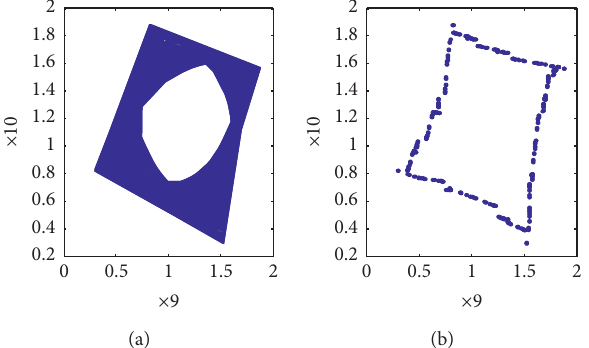
Figure 11: ω � 243 without random perturbation. (a) Phase trajectories. (b) Poincare